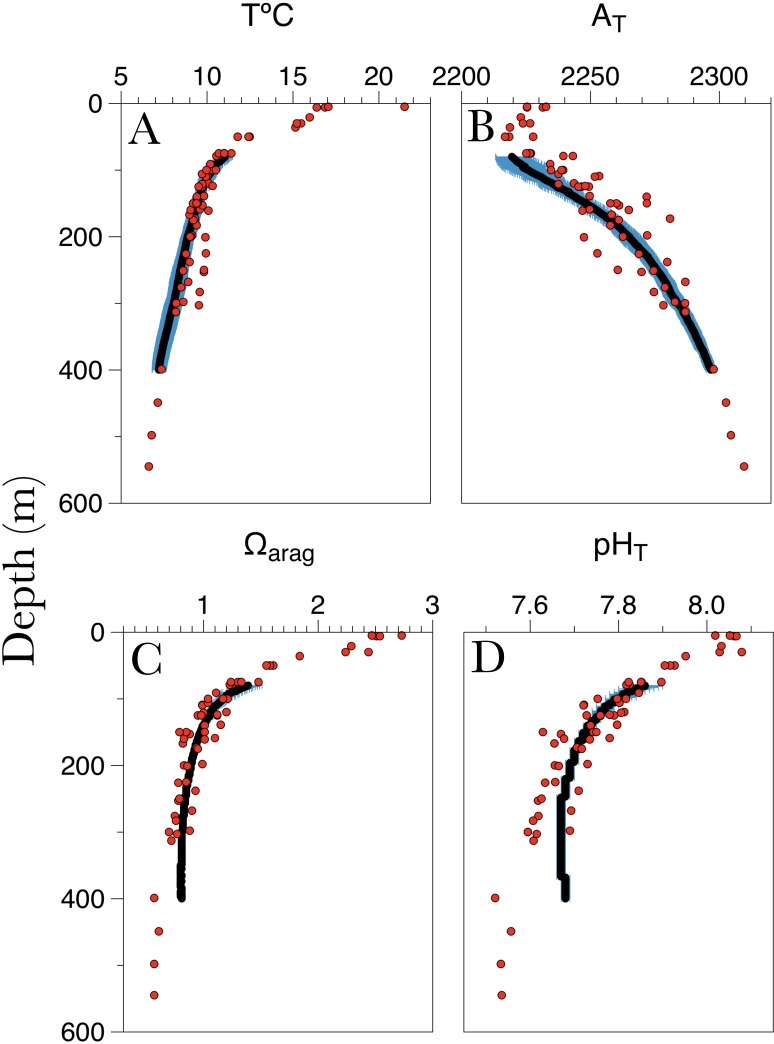
Water column profiles for (A) temperature (T °C), (B) total alkalinity (AT), (C) aragonite saturation (Ωarag) and (D) pHT(total scale) in the study site plotted against depth.Solid line indicates the average (±SD) of the seawater chemistry approximated from the CalCOFI database spanning a whole year from Nov 2014 to Nov 2015 the red dots represent the seawater chemistry from discrete water samples taken in the area of the collection sites. pH\documentclass[12pt]{minimal}
\usepackage{amsmath}
\usepackage{wasysym}
\usepackage{amsfonts}
\usepackage{amssymb}
\usepackage{amsbsy}
\usepackage{upgreek}
\usepackage{mathrsfs}
\setlength{\oddsidemargin}{-69pt}
\begin{document}
}{}${}_{\mathrm{T}}^{\mathrm{es}}$\end{document}Tes and A\documentclass[12pt]{minimal}
\usepackage{amsmath}
\usepackage{wasysym}
\usepackage{amsfonts}
\usepackage{amssymb}
\usepackage{amsbsy}
\usepackage{upgreek}
\usepackage{mathrsfs}
\setlength{\oddsidemargin}{-69pt}
\begin{document}
}{}${}_{\mathrm{T}}^{\mathrm{est}}$\end{document}Test where obtained from the empirical model proposed by Alin et al. (2012) for the South Atlantic Bight for pHT and AT.